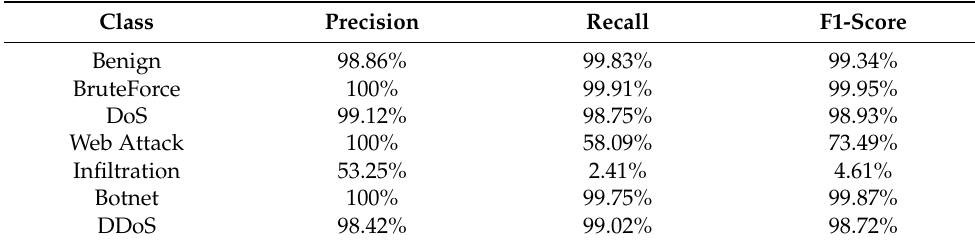
Table 25. CNN + RNN evaluation results for multi-class classification.